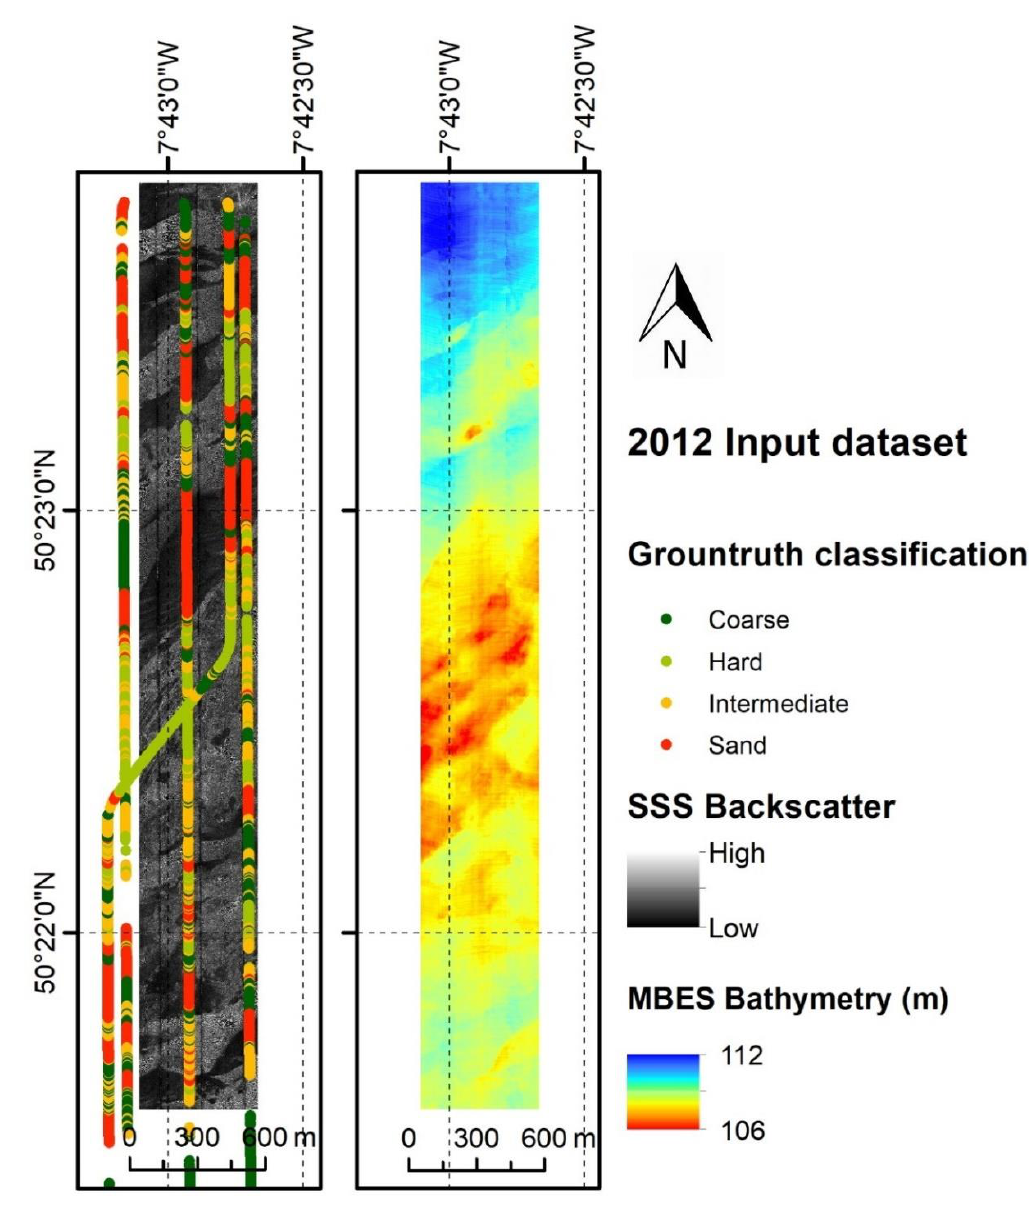
Figure 2. Geophysical datasets and groundtruth data points from 2012 survey. Left, AUV sidescan sonar map with classified groundtruth points. Right, AUV multibeam echosounder bathymetry data of the same area. Mercator projection with standard parallel 50. WGS84 datum. Table 1. Sidescan sonar backscatter acquisition parameters.